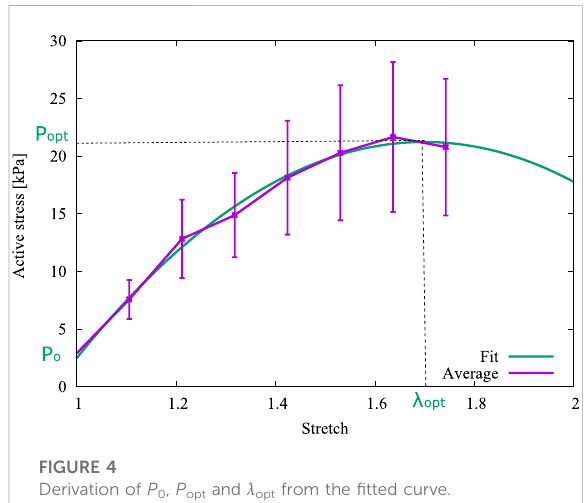
Derivation of P 0 , P opt and λ opt from the fi tted